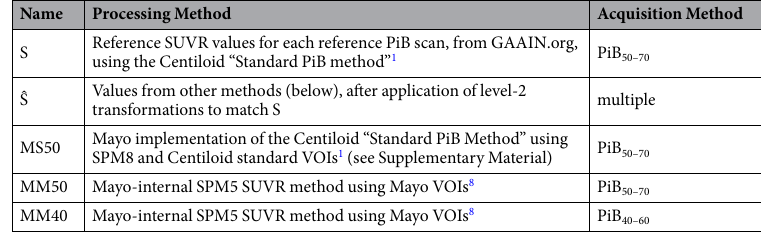
Table 1. Glossary of datasets used in this work.